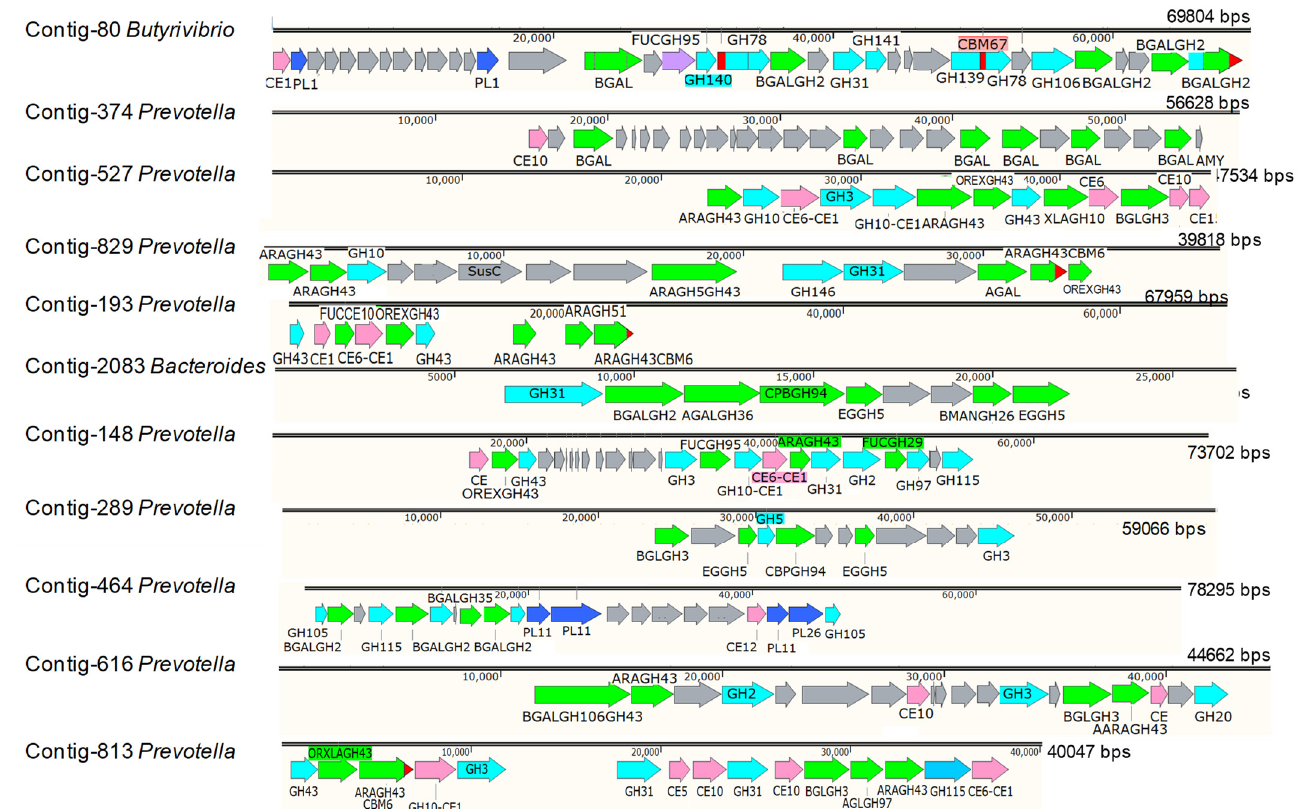
Figure 5. Celluloses/hemicelluloses utilization loci in some potential contigs assembled from metagenomic deep se- quencing data of bacteria in goats’ rumen. CE: esterase; GH: glycosylase; PL: Polysaccharide lyase; EG: Endoglucanase ; CBM: carbohydrate binding model; BGL: Beta glucosidase; XLA: Endo- β -1,4 xylanase; OREX: Oligosaccharide reduc- ing-end xylanase; XBX: Xylan 1,4-beta-xylosidase; BGAL: Xyloglucan-active β -D-galactosidase; AGAL: Al- pha-galactosidase; ARA: Alpha-L-arabinofuranosidase; AFUC, FUC: Alpha-L-fucosidase; BMAN: Beta-mannanase ; AGL: Alpha glucosidase; AMY: amylase.